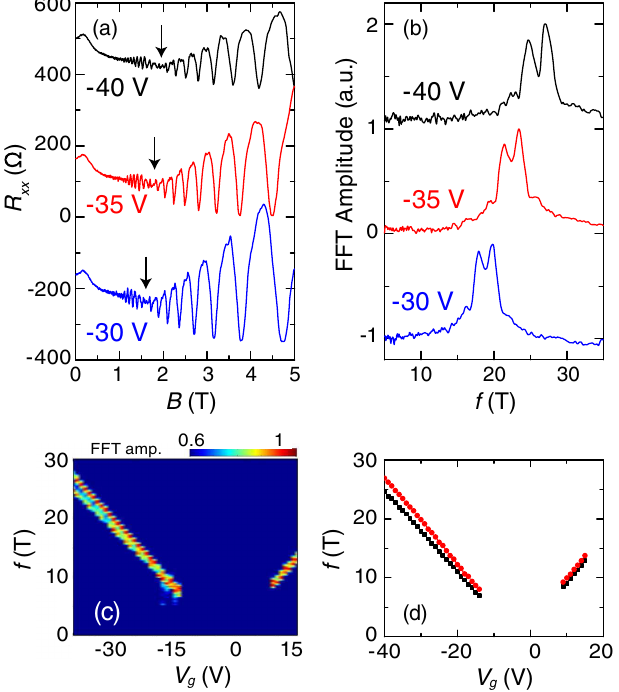
FIG. 7. Extracting SOI from the SdH resistance oscillations observed in BLG-on-WSe 2 devices. (a) SdH resistance oscilla- tions exhibit a beating pattern whose node position shifts with the applied gate voltage V (curves are vertically offset for clarity; the g ¼ − 2 V). (b) Peak charge neutrality point in this device is at V g splitting in the Fourier spectra of the data shown in (a) is used to determine the SdH frequency splitting. (c) Color-coded Fourier spectrum plotted vs frequency f and gate voltage V . (d) The g position of the two peaks in the Fourier spectra shown in (c) plotted vs V (black and red circles represent the lower g and higher frequency peaks, respectively). The dependence on V g indicates that the SdH frequency splitting increases as the carrier density